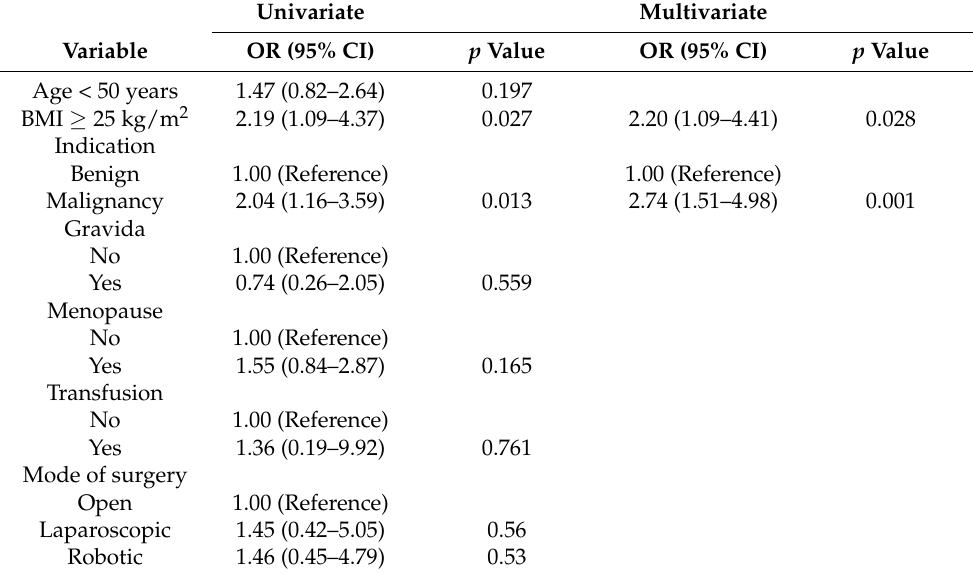
Table 3. Logistic regression analyses of factors influencing vaginal cuff